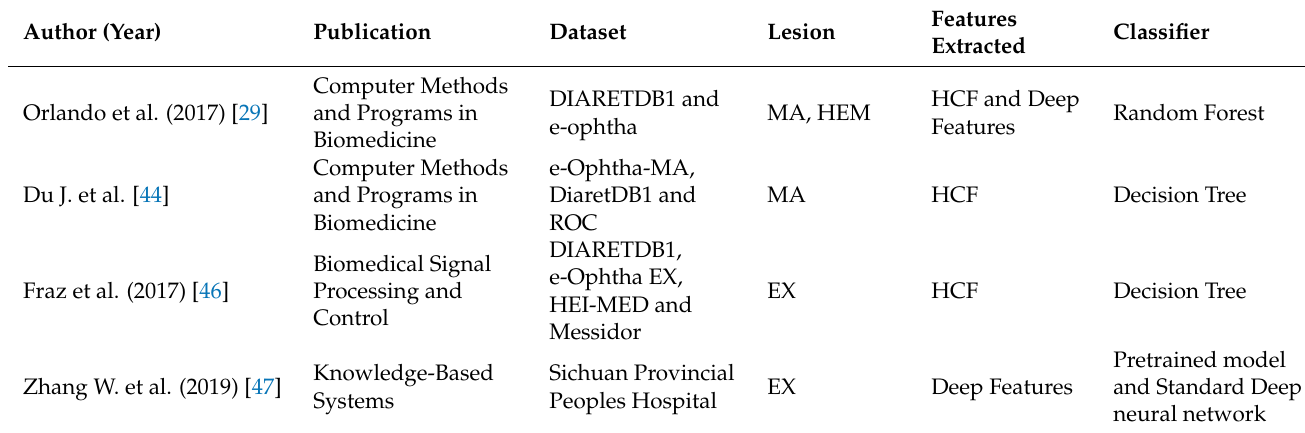
Table 9. Ensemble learning styles used in the literature.